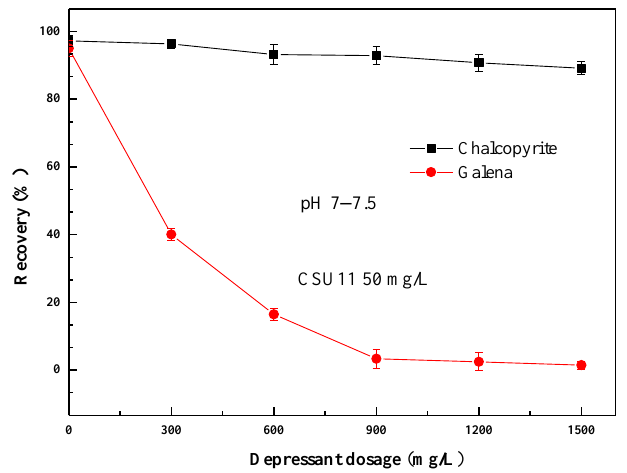
Figure 6. Effect of depressant mixture D Final concentration on single mineral flotation behavior.